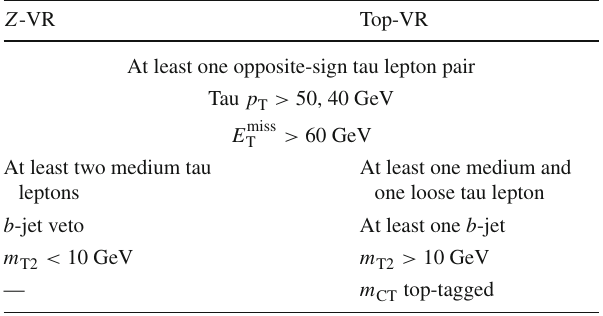
Table 6 The Z -VR (left) and Top-VR (right) definitions